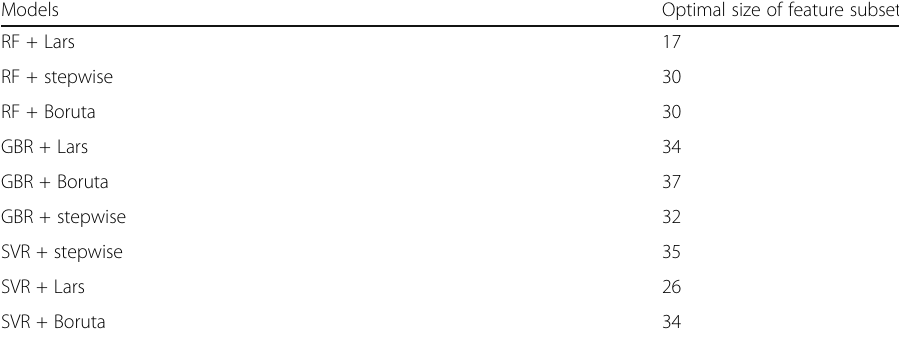
Table 3 The optimal feature size of nine hybrid models